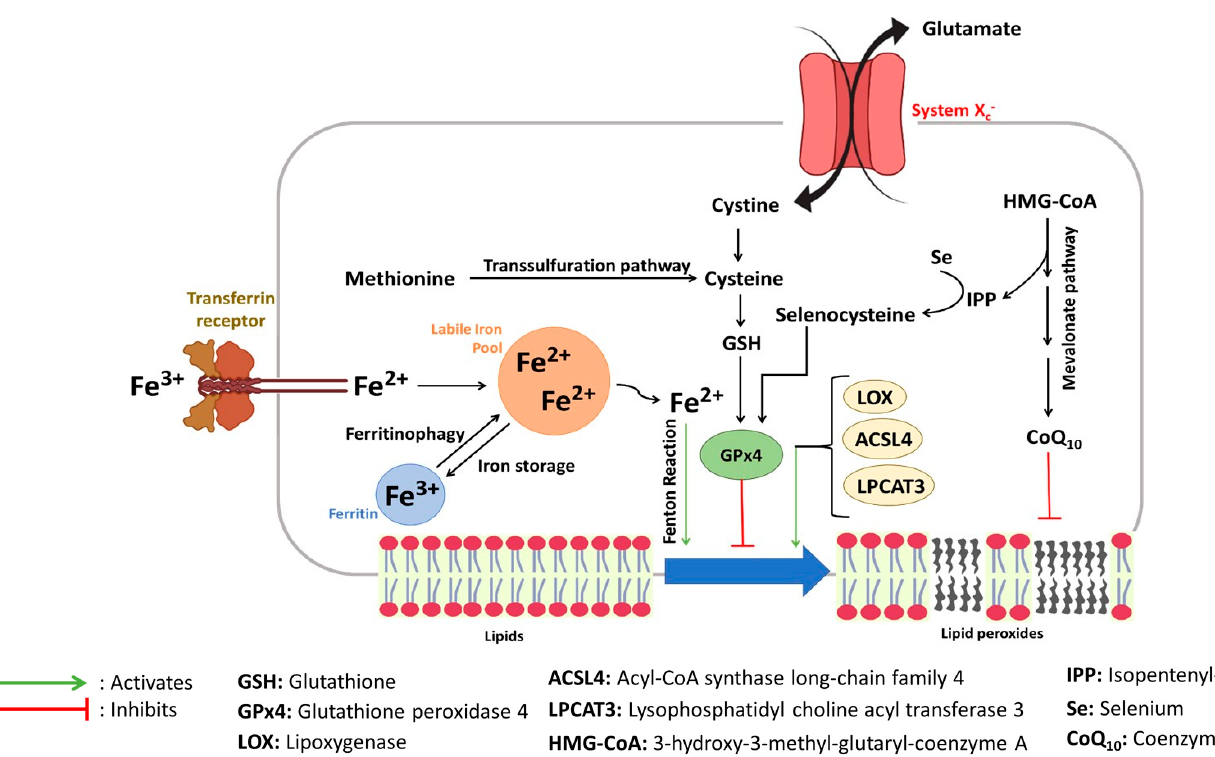
Figure 3. Network of ferroptosis signaling pathways .